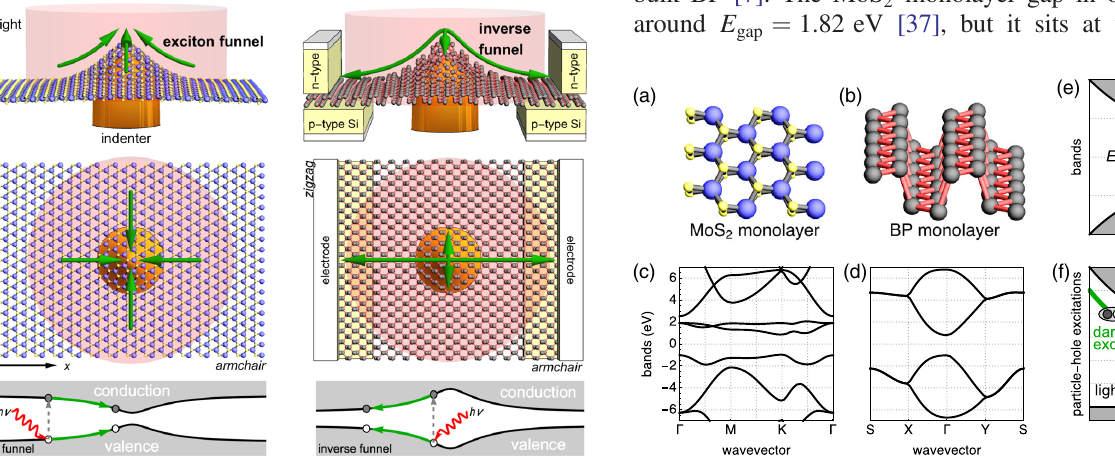
FIG. 1. An exciton funnel for MoS 2 is represented in (a), where an indenter creates an inhomogeneous strain profile that modulates the gap (bottom) and pushes photogenerated excitons (in green) isotropically towards the center of indentation. In BP (b), the same strain profile creates a stronger, highly anisotropic inverse funnel effect that pushes excitons away from the indentation along the armchair direction.